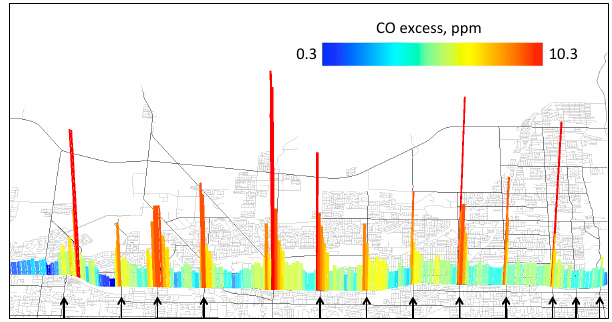
Figure 4. The CO mole fraction along a north–south segment of Bangerter Highway in Salt Lake Valley, Utah, USA. Values shown represent mole fraction above background mole fraction obtained from Wendover, Utah. The color bar shows the range of values ob- served. The underlying black and white grid shows roads, where the highest mole fraction values (red peaks) coincide with inter- section locations. Intersections associated with traffic signals are shown with black